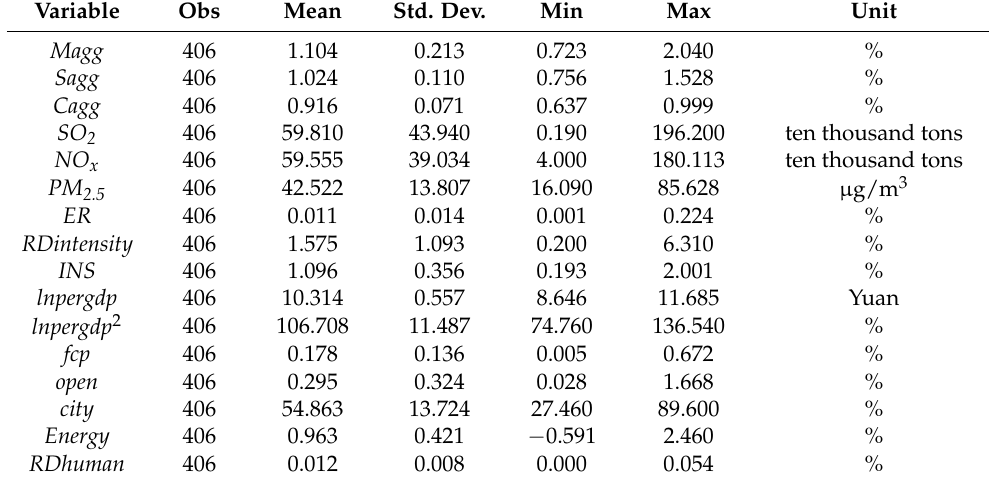
Table 2. Descriptive statistics of all